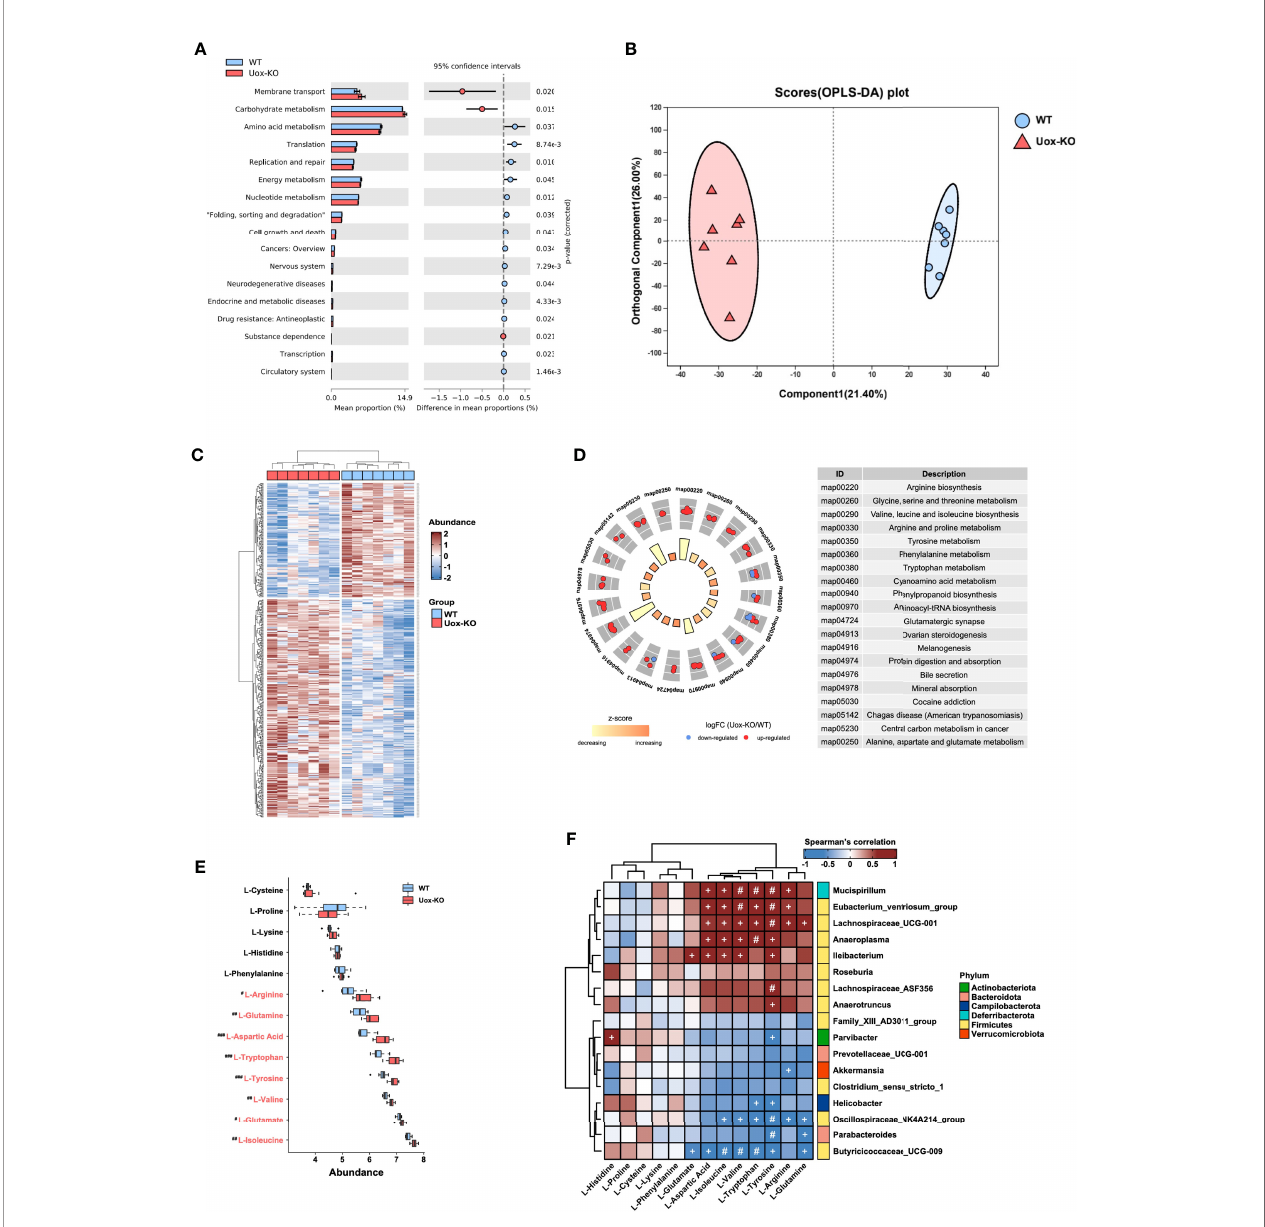
FIGURE 2 | Gut microbiota affects host amino acid metabolism. (A) The functional potential of the bacterial communities on the basis of 16S rDNA sequencing pro fi les was predicted by PICRUSt2. The main metabolic functions involved include membrane transport, carbohydrate metabolism and amino acid metabolism. (B) The OPLS-DA score plot (the circle represents samples with 95% con fi dence interval). (C) The heatmap presentation of differential metabolites. (D) The top twenty enriched KEGG pathways of differentially expressed metabolites. (E) The relative abundance of fecal amino acids in WT mice and Uox -KO mice (N = 7 mice/ group). Blue and red denote WT-enriched and Uox -KO enriched amino acids, respectively. Values are expressed as mean ± SEM. # denotes amino acids differed in abundance between WT and Uox -KO samples. # p < 0.05; ## p < 0.01; ### p < 0.001. (F) Spearman ’ s rank correlation analysis was conducted between discrepant microbial taxa and fecal amino acids. Positive correlations are displayed in red and negative correlations in blue. The intensity of the color is proportional to the correlation coef fi cient. + p < 0.05; # p <